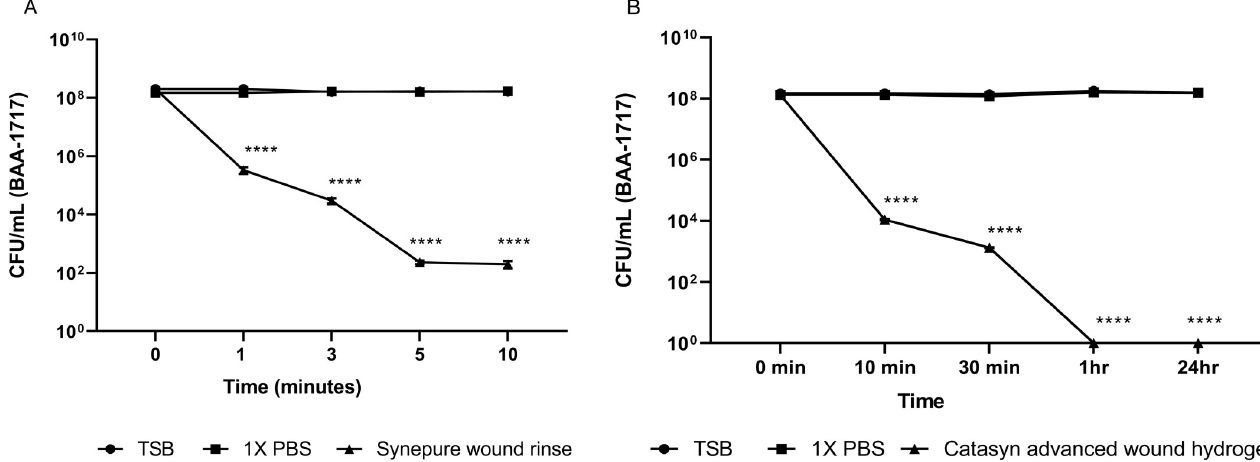
Fig 2. Treatment with wound rinse (A) and wound gel (B) lead to significant decrease in the viable bacteria in 72hr grown MRSA (ATCC 1 BAA-1717 ™ ) biofilm as reflected by remaining bacteria (CFU/ml). Data represented as the mean CFU/ml +/- SEM. ���� , p < 0.0001.